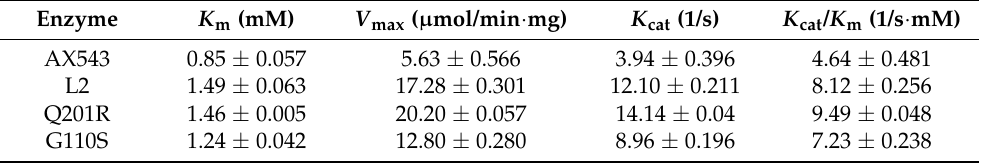
Table 3. The kinetic parameters of AX543 and mutants L2, G110S, and